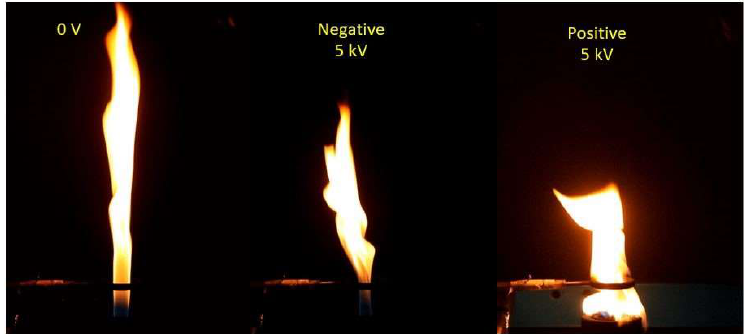
Figure 4. The change in flame shape by electric